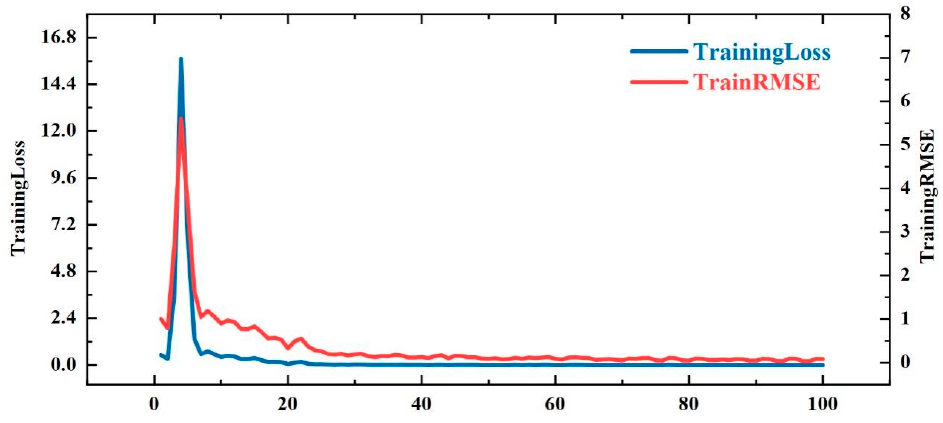
Figure 8. Training loss and RMSE values of IMF3.